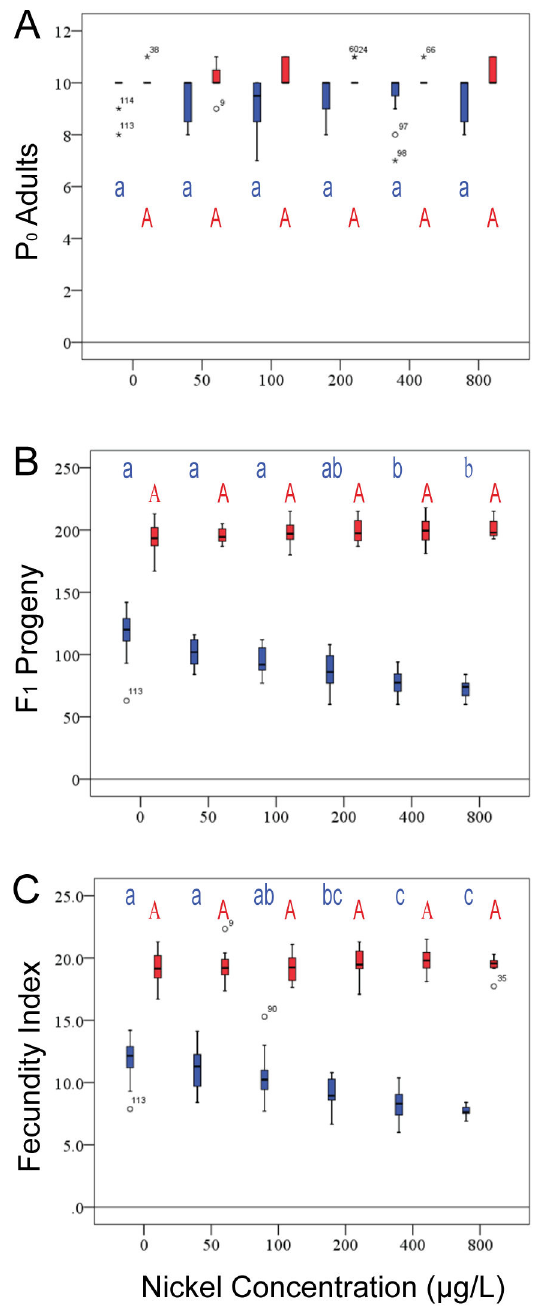
Figure 5. Recovery of P0 adult nematodes and F1 progeny from nickel-spiked water. C. elegans – blue. P. pacificus – red. (A) P0 recovery. (B) F1 recovery. (C) Fecundity